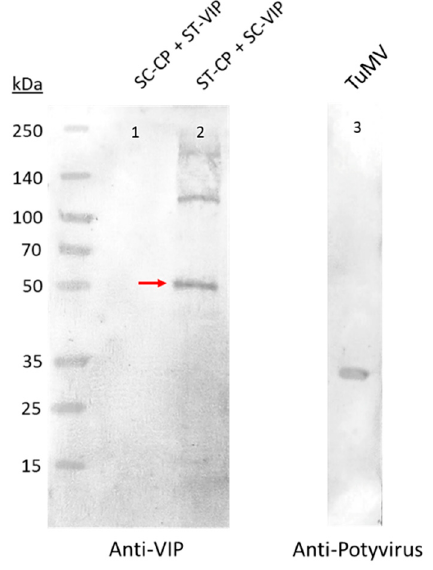
7 of 12 Figure 4. Representative TEM micrographs of the two co-agroinfiltrated constructs of TuMV VLPs- GFP using the SpyTag/SpyCatcher conjugation technology (SC-CP + ST-GFP and ST-CP + SC-GFP). VLPs treated with primary anti-GFP antibody are on the left and central panels. ST: SpyTag; SC: SpyCatcher; CP: TuMV capsid protein; GFP: green fluorescent protein; C-: negative control of an eVLP (ST-CP + SC-GFP) without treatment with the primary anti-GFP antibody. Regarding the constructs with VIP, Western blot analyses revealed that one of the